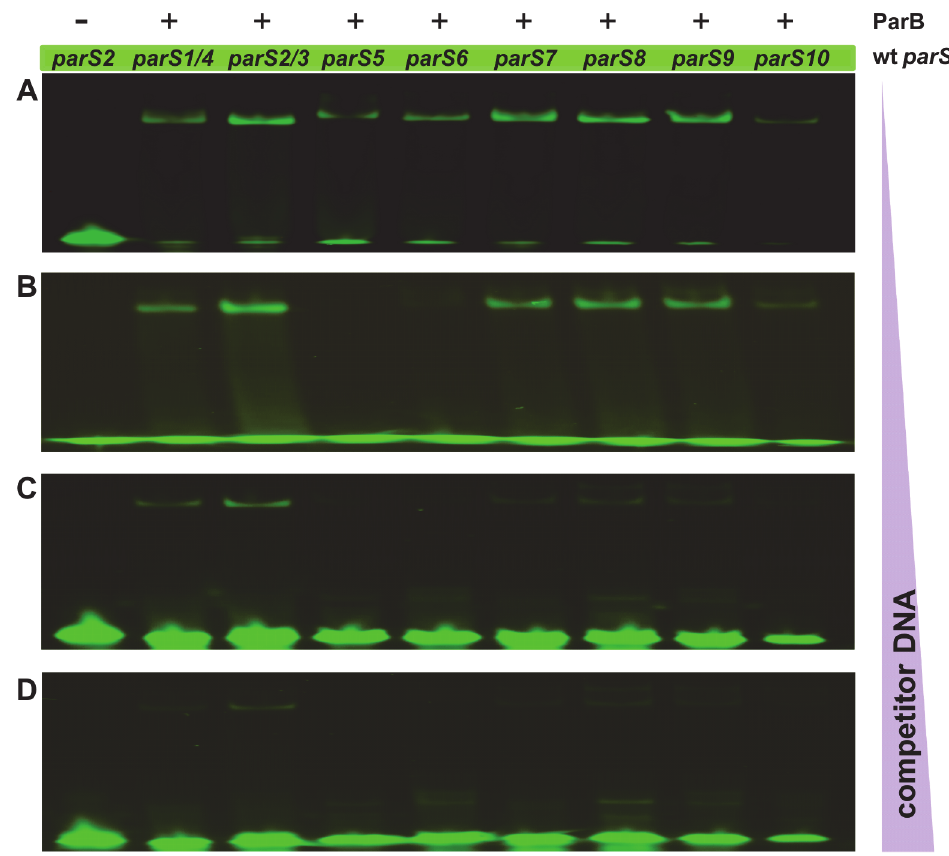
Fig 4. The hierarchy of ParB binding to parS sequences. Fluorescently labelled ds parS oligonucleotides (6 pmoles) were incubated with 240 pmoles of His 6 -ParB and increasing amounts of unlabelled ds parS2